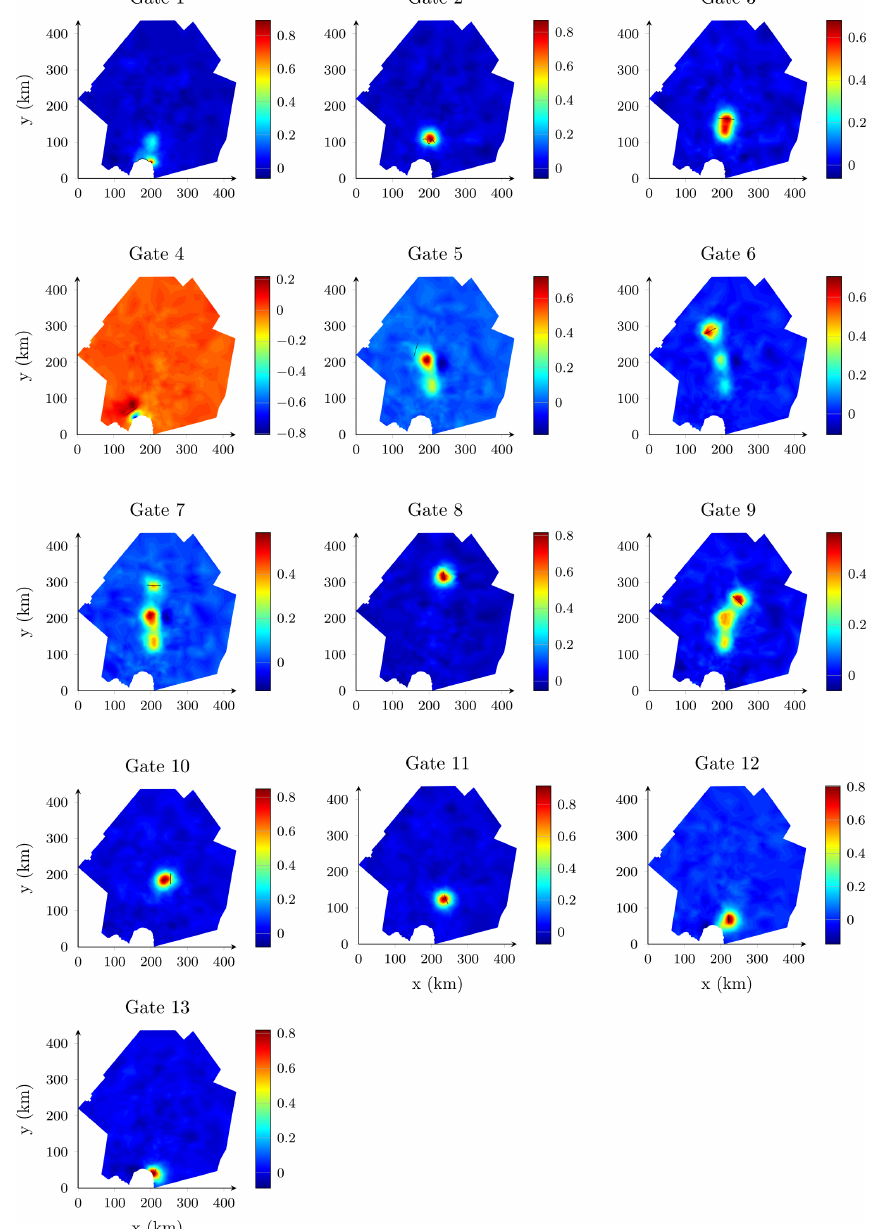
Figure 11. Sensitivity map (visual representation of the coefficient of correlation) for mass flux across fluxgates depicted in Fig. 5. Results are for a parameter range of